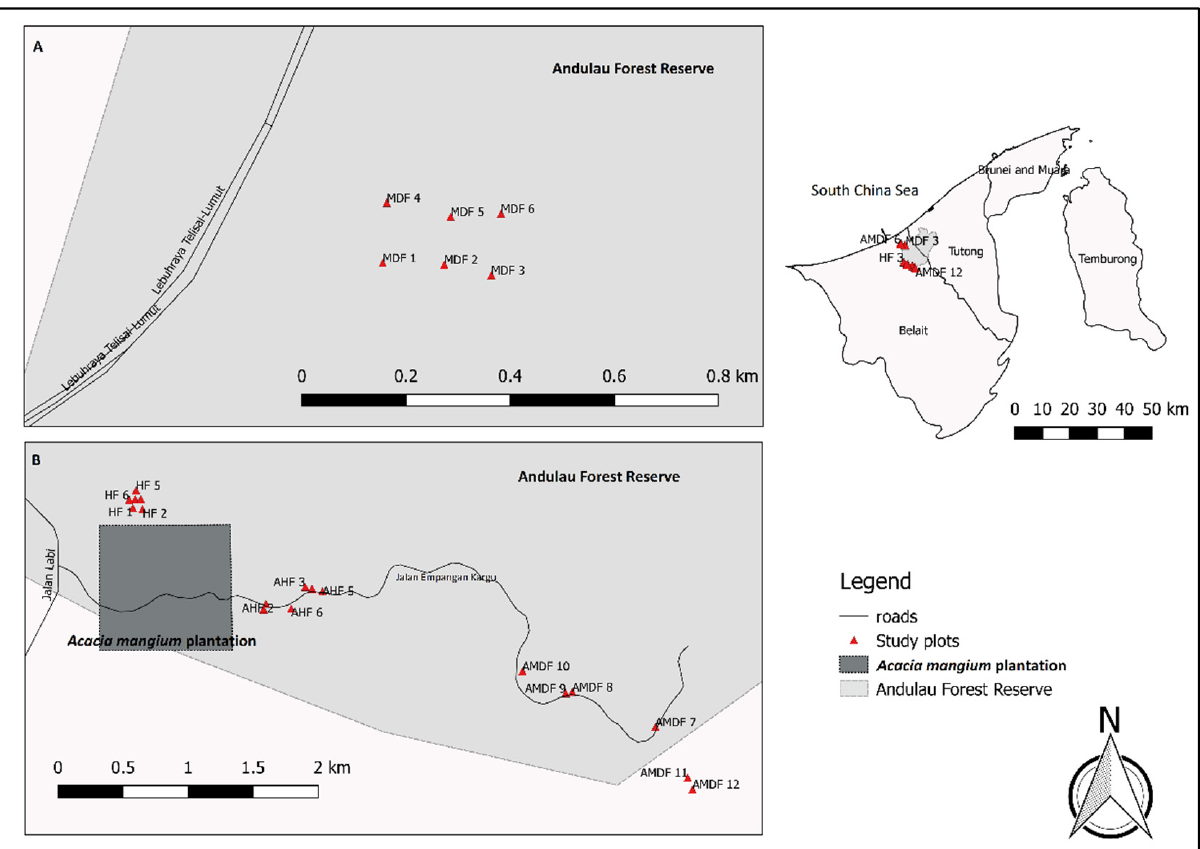
Figure 1. Locations of the study sites containing six plots (20 m × 20 m) in each of the intact heath forest (HF 1–6), Acacia -invaded heath forest (AHF 1–6), intact mixed-dipterocarp forest (MDF 1–6) and Acacia -invaded mixed dipterocarp forest (AMDF 7–12) within Compartments 7 and 8 of the Andulau Forest Reserve in the Belait District, Brunei Darussalam. AHF and AMDF plots along the Jalan Empangan Kargu roadsides were set up in areas invaded by Acacia trees. Distances between plots within the same habitat type ranged from ca. 50–500 m. ( A ) represents the inset of plots MDF 1–6, and ( B ) represents the inset of plots HF 1–6, AHF 1–6, and AMDF 7–12. To ensure that the abundance of trees within all plots did not influence litter and soil properties, all trees with diameter breast height (dbh) ≥ 1 cm in all plots were counted, and no significant differences were recorded in mean ( ± SEM) tree abundance (HF = 411 ± 12.3, AHF = 348 ± 7.40, MDF = 327 ± 8.72, AMDF = 277 ± 15.7; F = 1.87, p > 0.05). All Acacia trees within the AHF and AMDF plots were identified as Acacia mangium , while trees within AHF and AMDF plots consisted of a mix of native species and A. mangium trees, respectively. The AHF and AMDF plots recorded a similar abundance of A. mangium